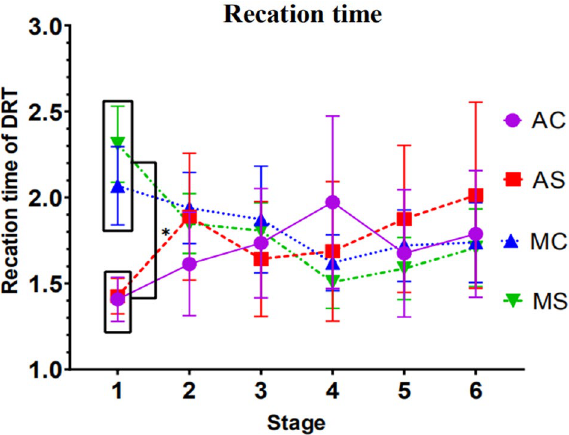
Figure 2. Trend in response time for detection response tasks (Note: Vertical bars represent standard errors, *p < 0.05).